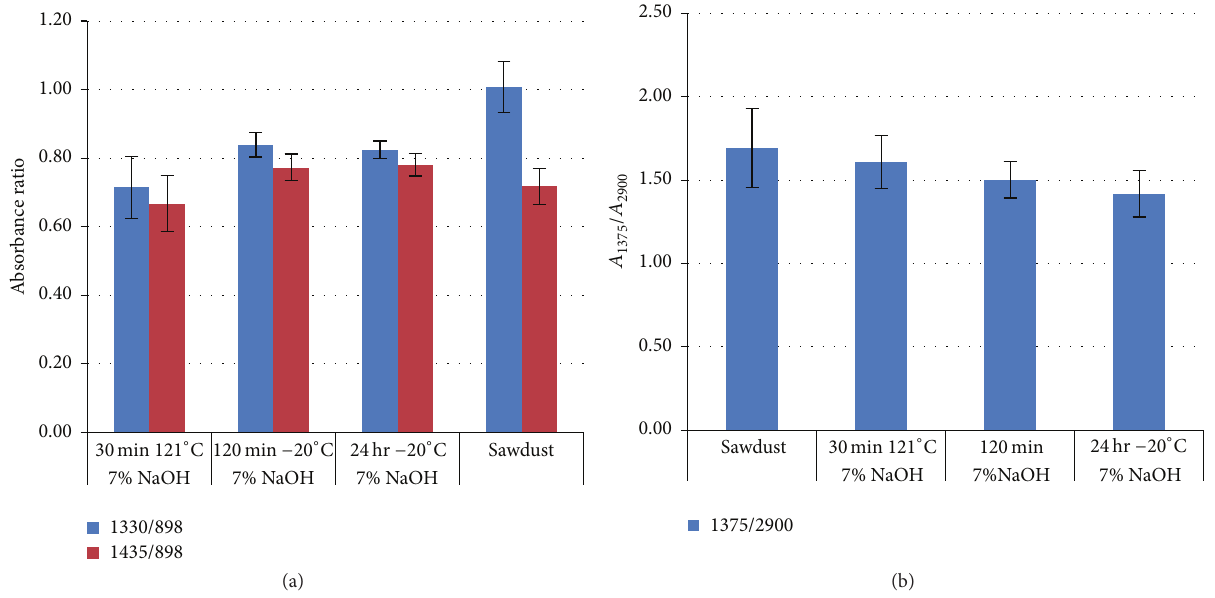
Figure 7: Crystallinity analysis of 7% NaOH extreme conditions: (a) comparison of absorbance ratios; (b) comparison of total crystallinity